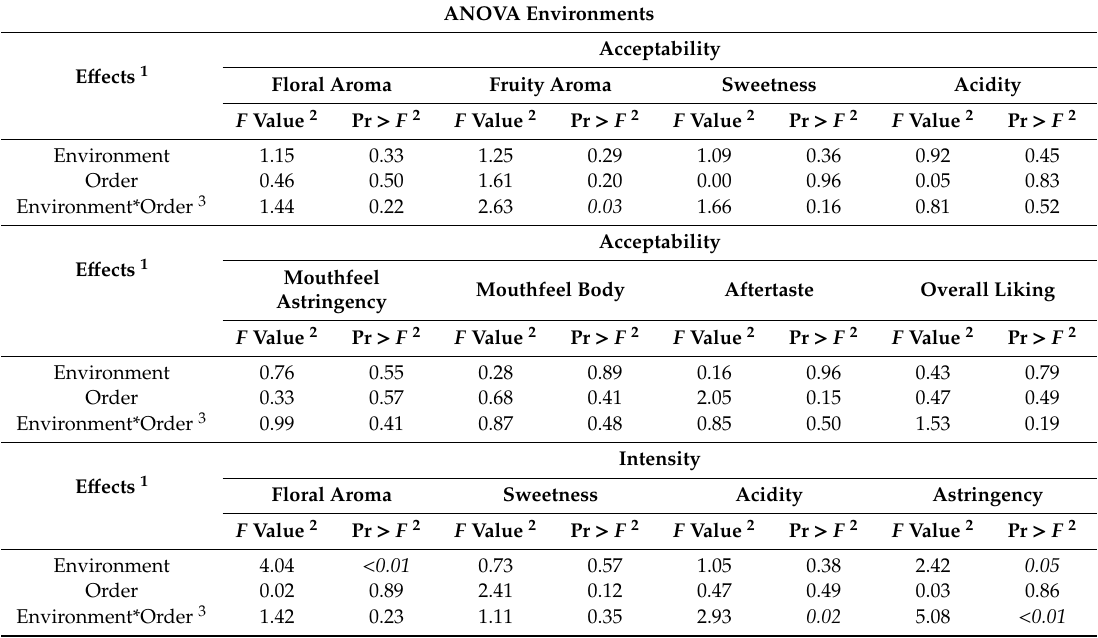
ANOVA 1 table for the acceptability and intensity parameters of the wine by environment